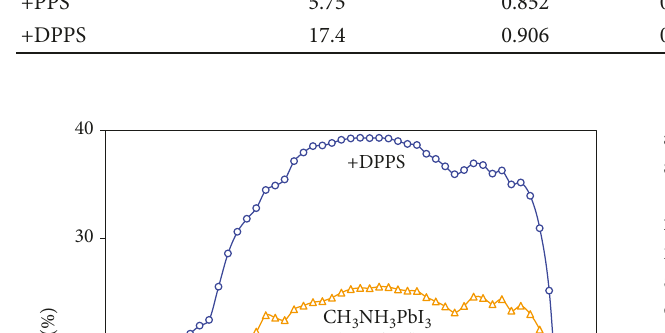
Perovskite layer